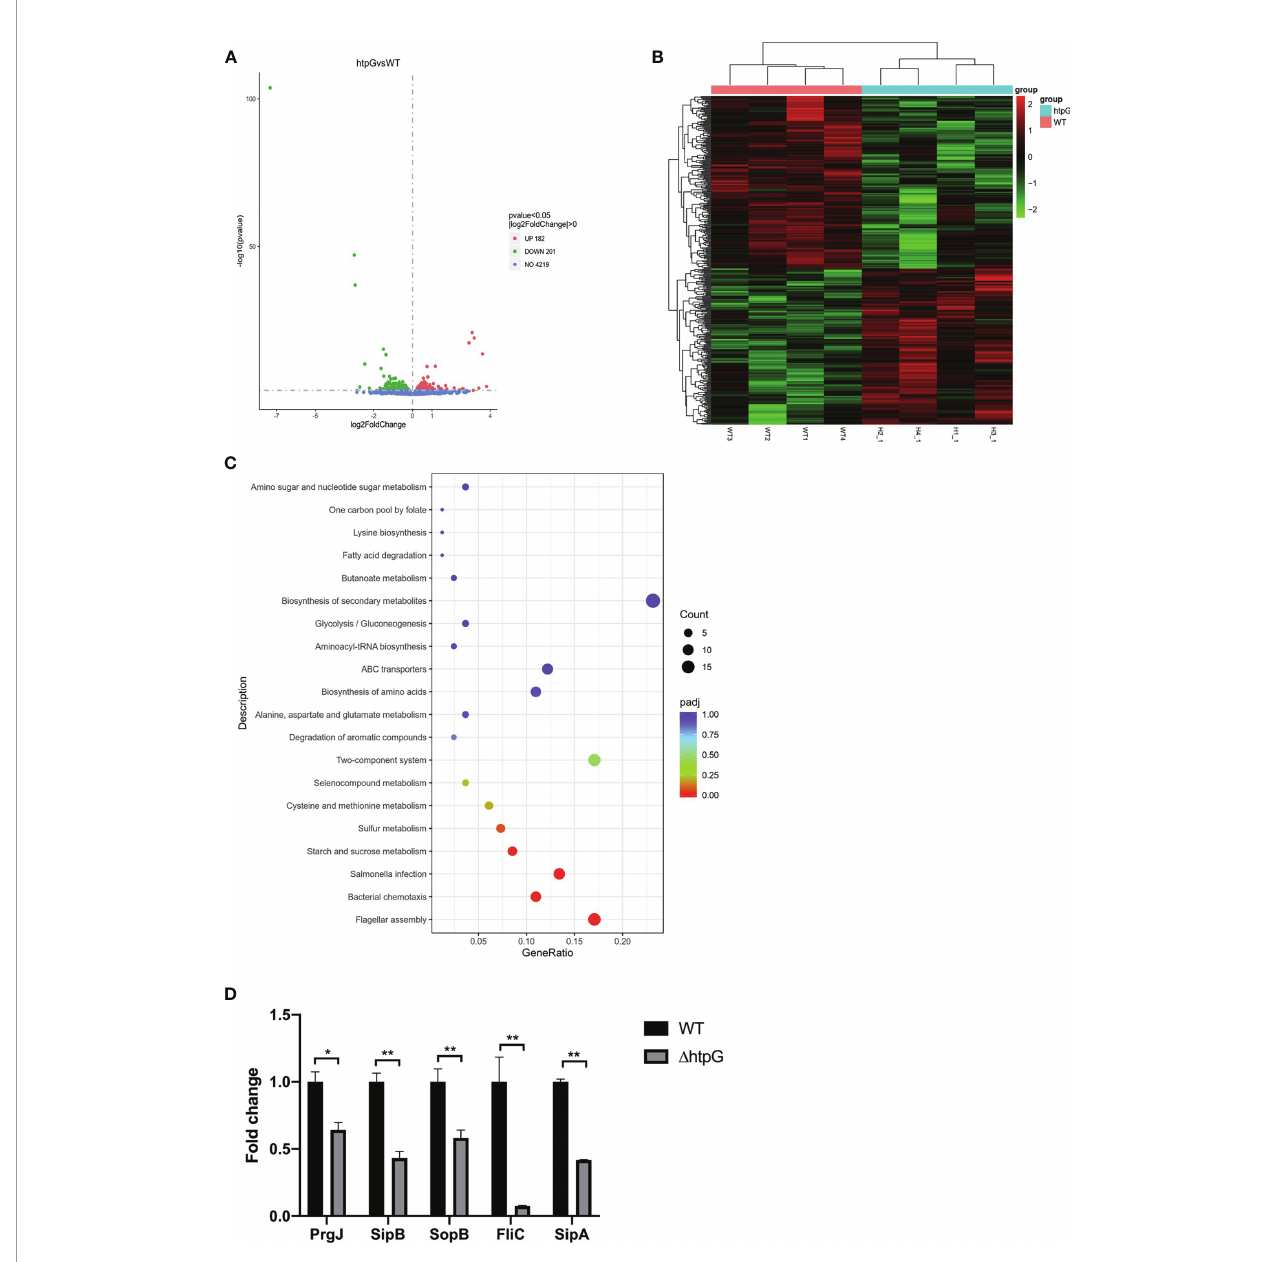
FIGURE 2 | (A) Difference analysis volcano map. UP (red): upregulation of differential genes, DOWN (green): downregulation of differential genes, NO (blue): total number of genes detected. (B) Cluster Heat Map of Differential Genes. (C) KEGG enrichment analysis scatter plot. Gene ratio: the ratio of the number of differential genes annotated to the KEGG pathway to the total number of differential genes. (D) Transcriptomics veri fi cation by qRT-PCR, * means p < 0.05, ** means p < 0.01, n =